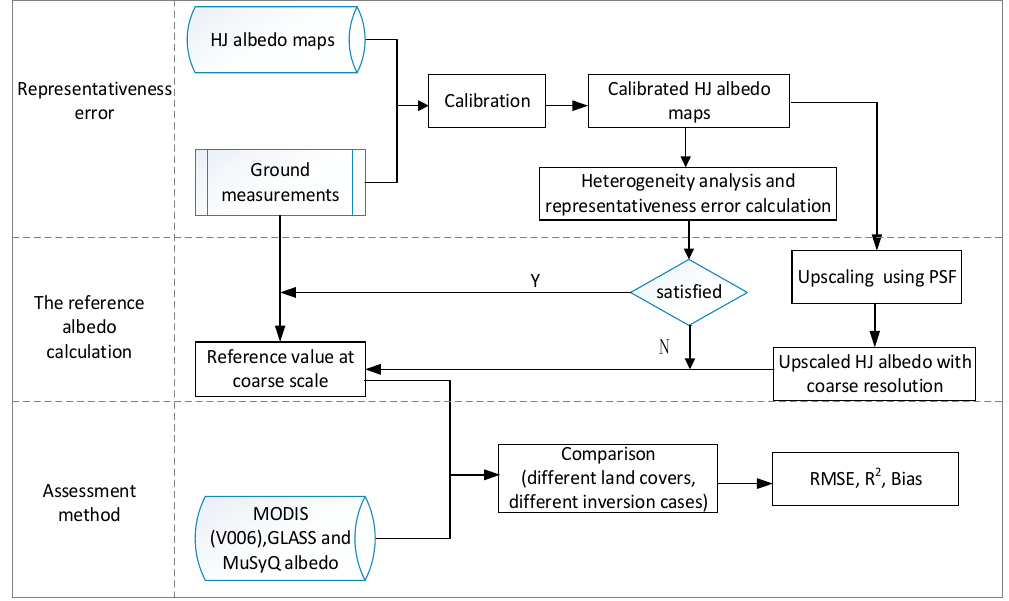
Figure 3. The flowchart of the assessment based on representativeness errors analysis. point spread function (PSF) denotes the point spread function of satellite albedo product.